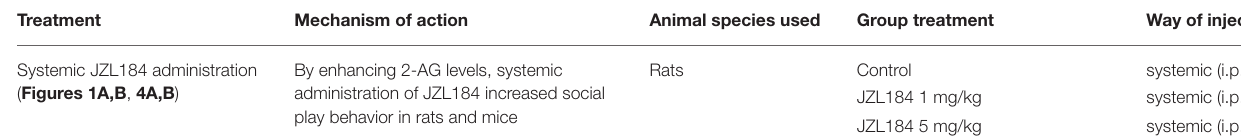
TABLE 1 | Behavioral experimental design.